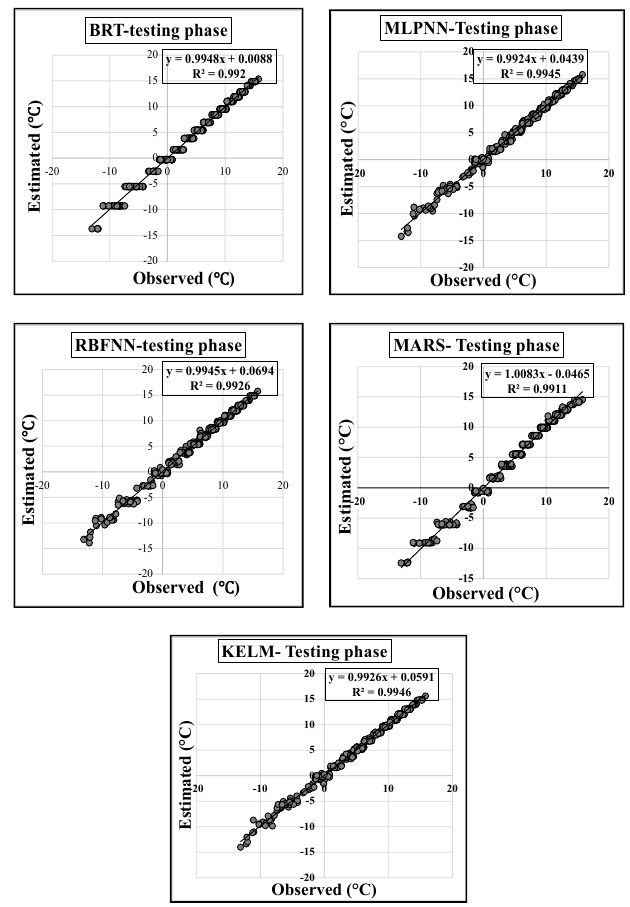
Figure 6. Comparison of observed and estimated daily T dew values using the best composite models (UC Riverside station).